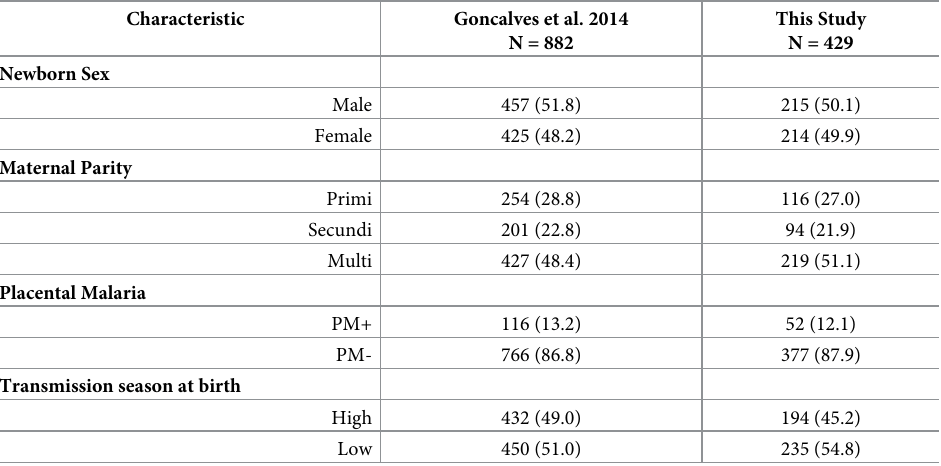
Table 1. Characteristics of children and samples included in the